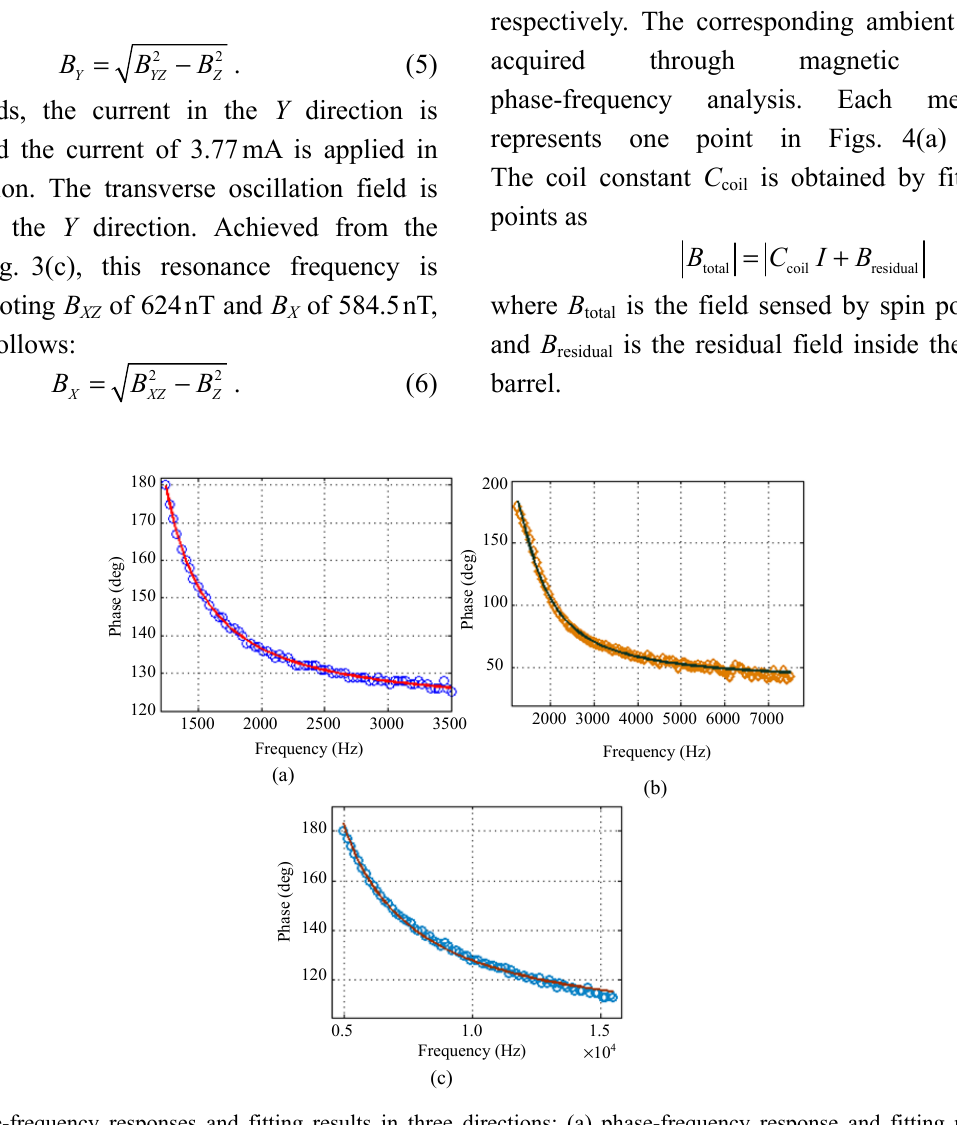
Fig. 3 Phase-frequency responses and fitting results in three directions: (a) phase-frequency response and fitting results under currents of 1 mA in the Z direction, with adjusted R 2 of 0.9984 and the resonance frequency of 1022 Hz, corresponding to B Z of 219 nT, (b) phase-frequency response and fitting results under currents of 1 mA in Z direction and 1.5 mA in the Y direction, with adjusted R 2 of 0.9946 and the resonance frequency of 1250 Hz and B Y of 154.2 nT, and (c) phase-frequency response and fitting results under currents of 1 mA in Z direction and ‒ 3.77 mA in the X direction, with adjusted R 2 of 0.9952 and the resonance frequency of 2913 Hz and B X of 584.5